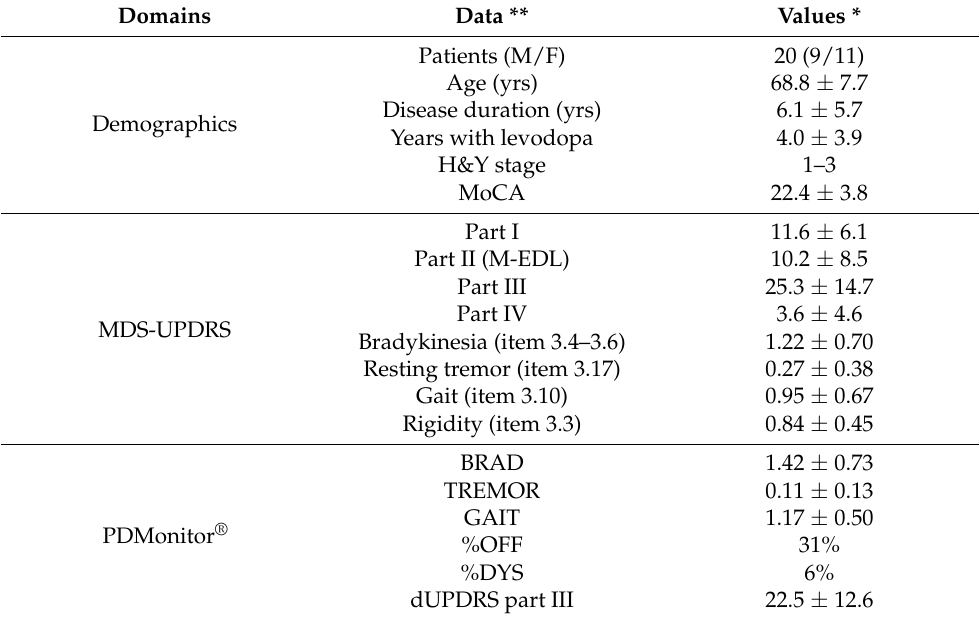
Table 1. The clinical- and PDMonitor ® -related characteristics of the